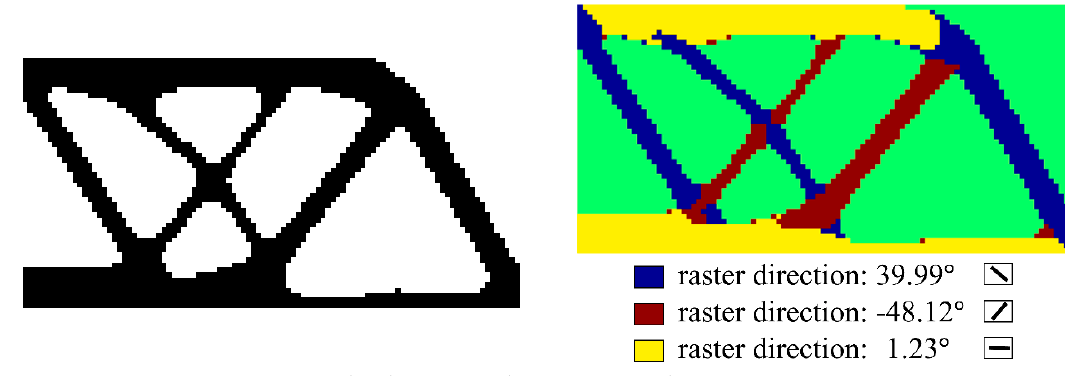
Figure 12. MBB structure optimization results (the blue color shows the converged ρ e 1 = 1 , the red color shows the converged ρ e 2 = 1 , the yellow color shows the converged ρ e 3 = 1 , and the green color shows the misconverged or void areas).